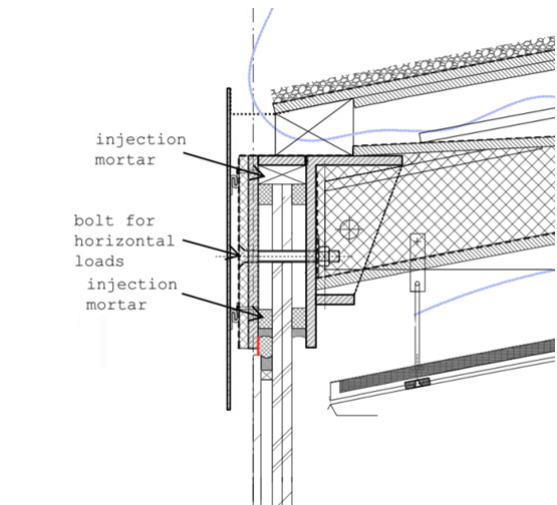
Fig. 13 Detail of the roof connection at the main hall.